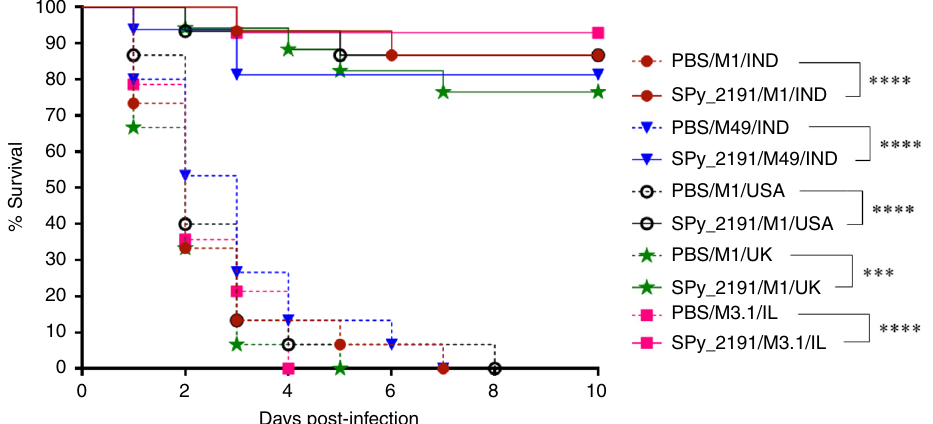
Fig. 5 SPy_2191 immunization provided cross-serotype protection against GAS. Survival of mice ( n = 12) from each group infected with different GAS serotypes, was monitored for death until 10 days. The results are presented as percent survival. To calculate the signi fi cance of difference in survival studies, the log-rank test (Mantel-Cox) was applied. *** P < 0.001; **** P < 0.0001. Survival curves were generated from two